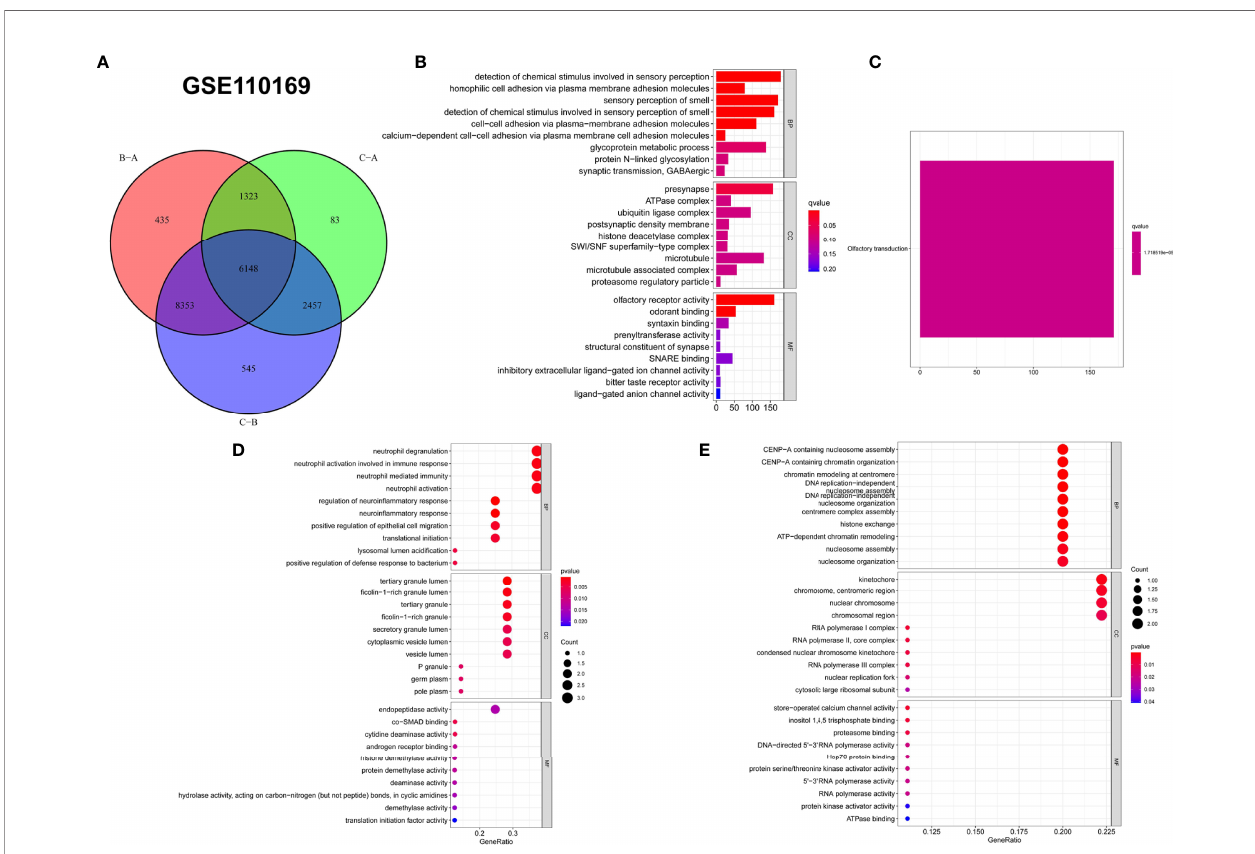
FIGURE 10 | Functional analysis was performed on the common genes identi fi ed by gene clusters and the immune genes in the GSE110169 cohort. (A) Venn diagram of the common genes from three gene clusters between SLE and normal samples. (B, C) The GO and KEGG enrichment results were used to analyze the molecular functions, cellular components, and biological processes of the common genes of gene clusters, identi fi ed by bar plots. (D , E) Bubble graphs for GO and KEGG enrichment analysis of the immune genes in the GSE110169